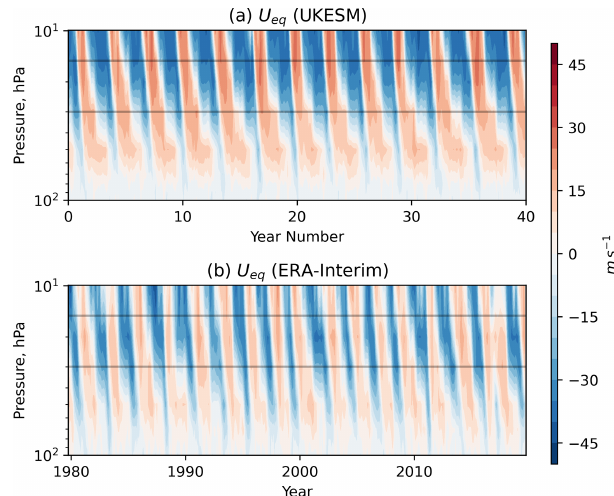
Figure 3. ZMZW averaged between 5 ◦ S–5 ◦ N latitude from a 40- year sample of the pre-industrial control simulation of UKESM (a) and the ERA-Interim dataset between 1979 and 2018 (b) . Horizon- tal lines mark the 15 and 30hPa levels between which the deep QBO metric employed by Andrews et al. (2019) is defined.